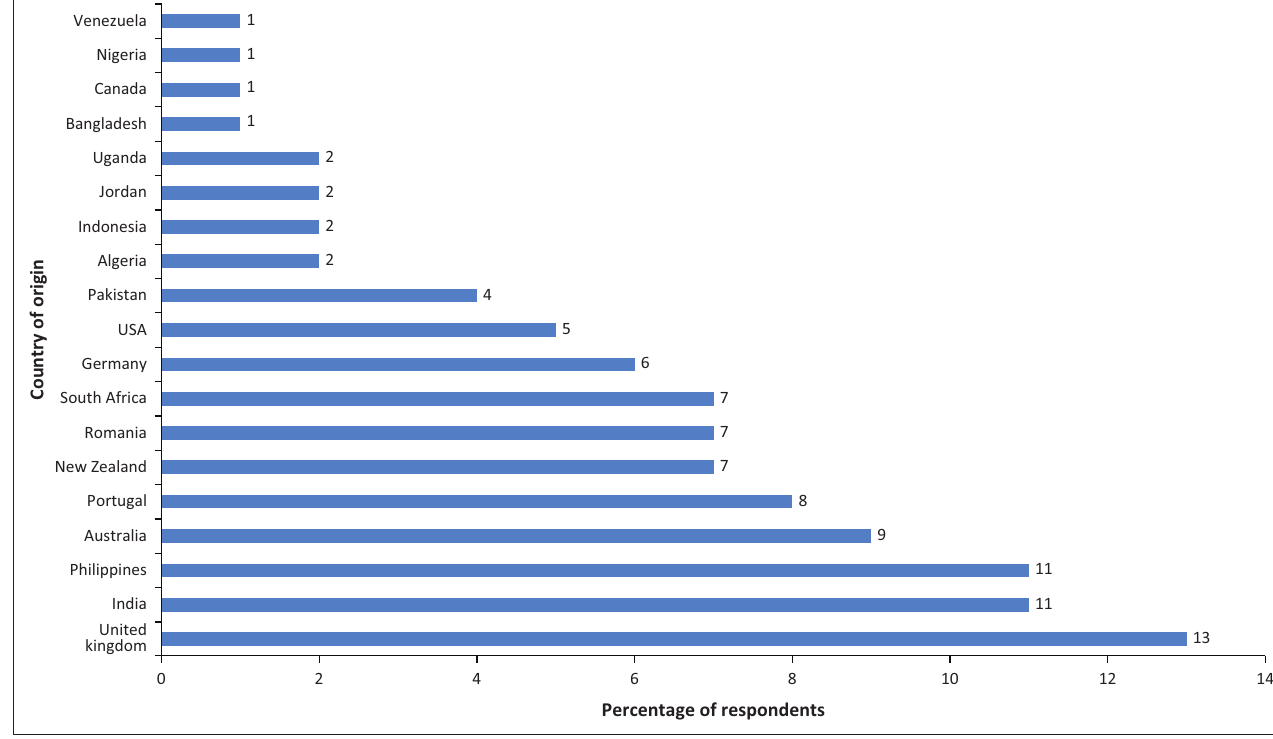
FIGURE 1: Expatriates’ country of origin.